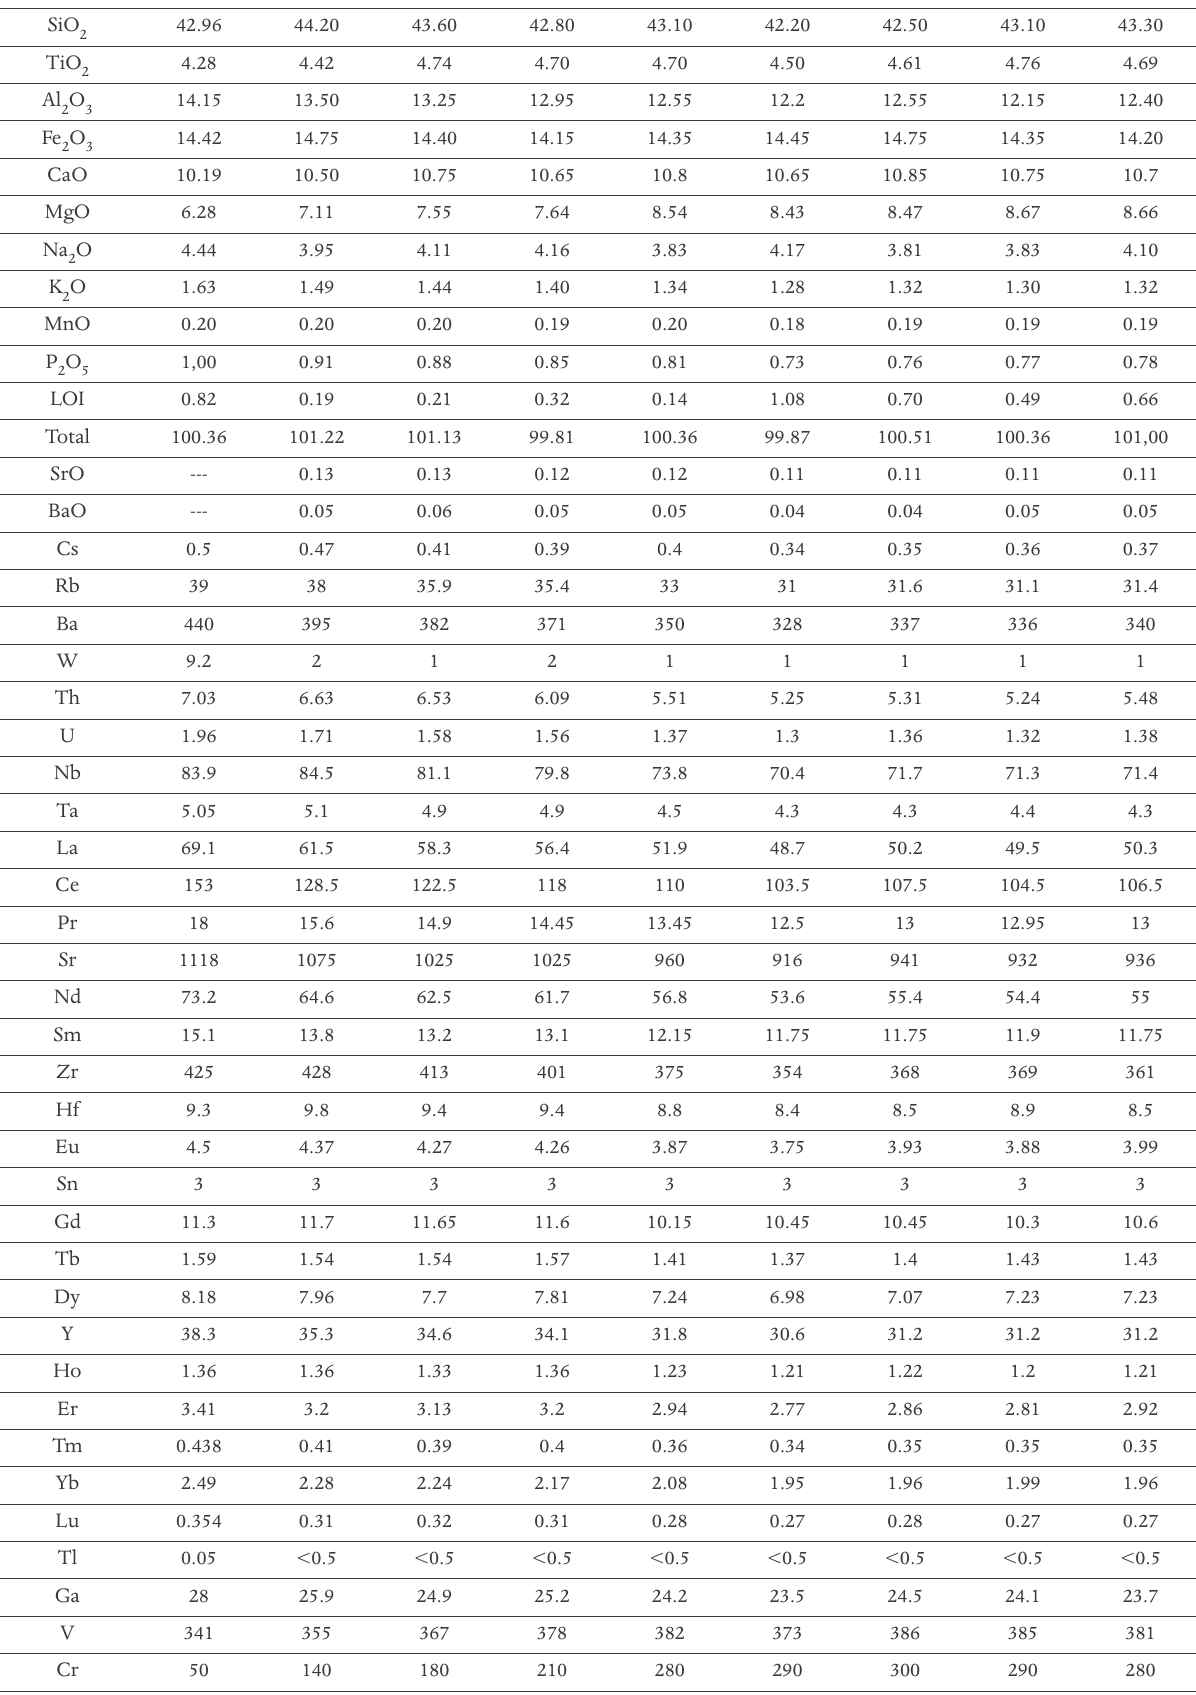
Table 3. Bulk rock major and trace elements chemical composition of studied